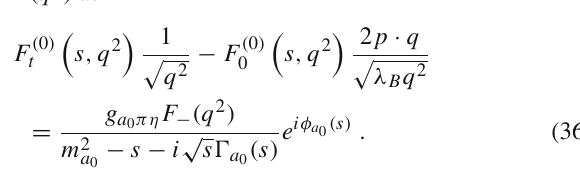
Fig. 3 The phase of the B 0 / D 0 → πη form factors, with the blue band showing the uncertainty from the Borel parameter and the LECs of ChPT ( 0 ) ( s , q 2 ) can be parameterized it here. Similarly, the F t